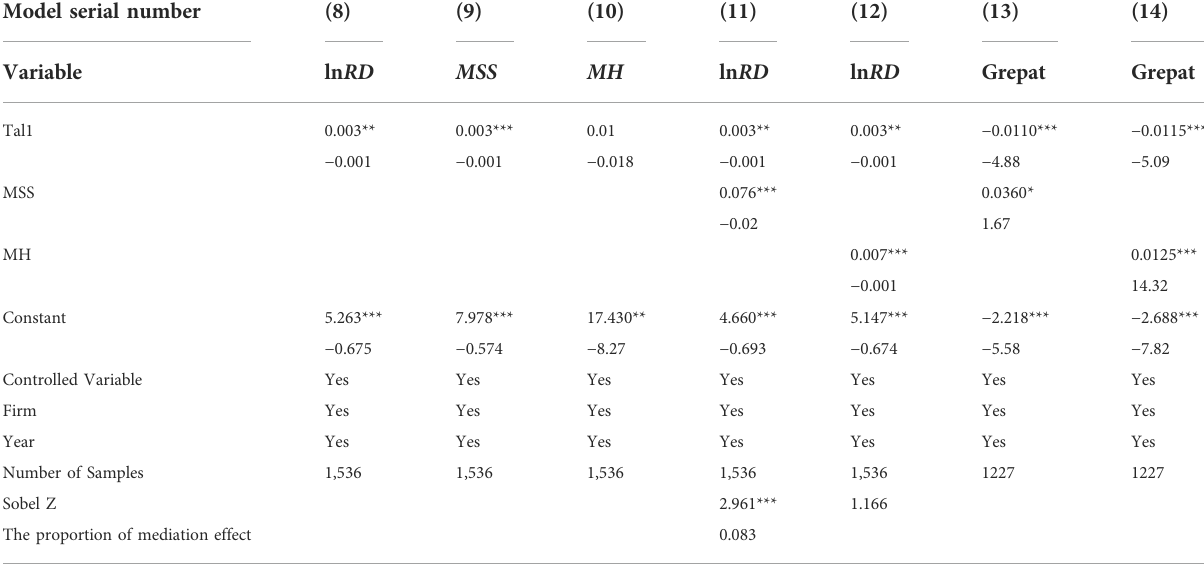
TABLE 4 Robustness